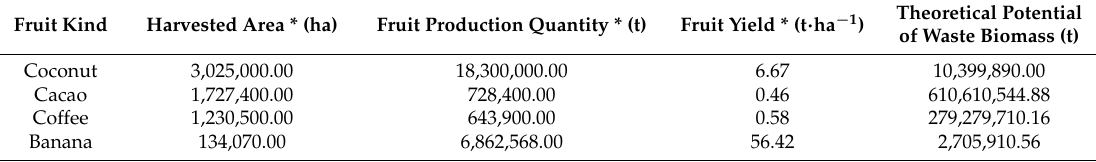
Theoretical Potential of Waste Biomass (t)